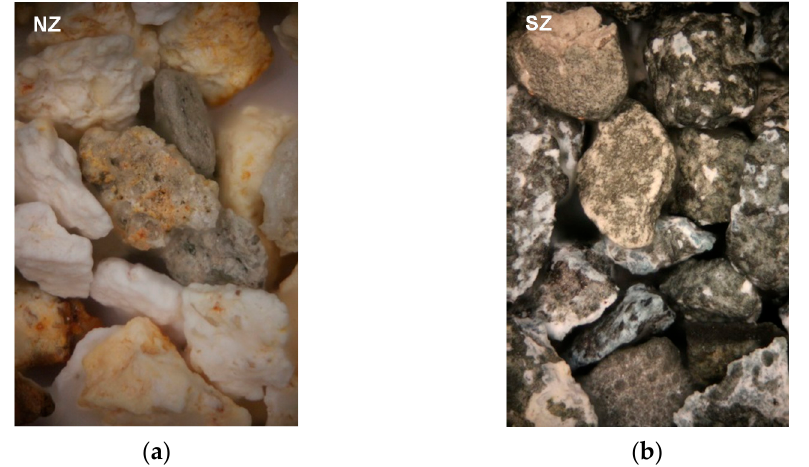
Figure 8. Optical micrographs of the ( a ) NZ and ( b ) SZ surface at a magnification of 50×. It was observed that NZ has a light color characteristic of aluminosilicate minerals.